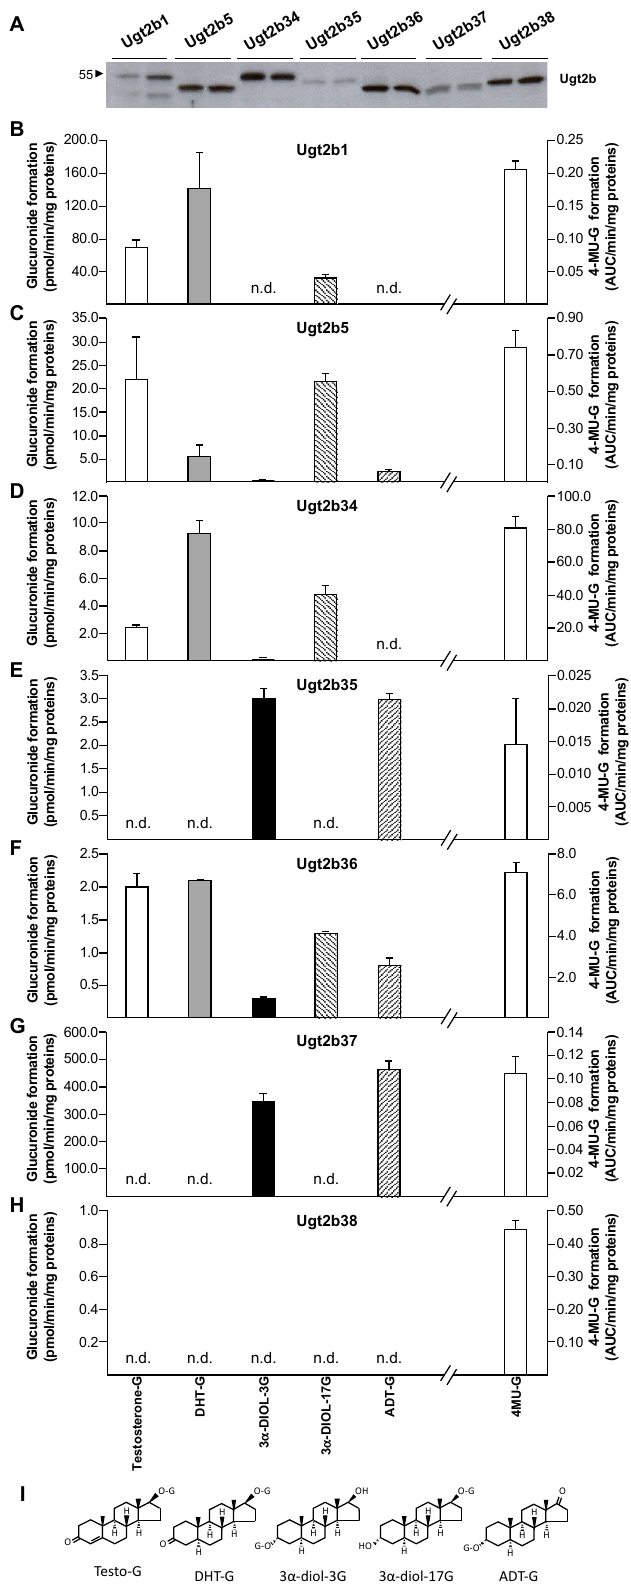
Figure 3. Stereoselectivity of male liver, kidney and recombinant murine Ugt2b enzymes for androgen glucuronidation. ( A ) Homogenates from Ugt2b-HEK293 cells (25 µ g) were size separated on